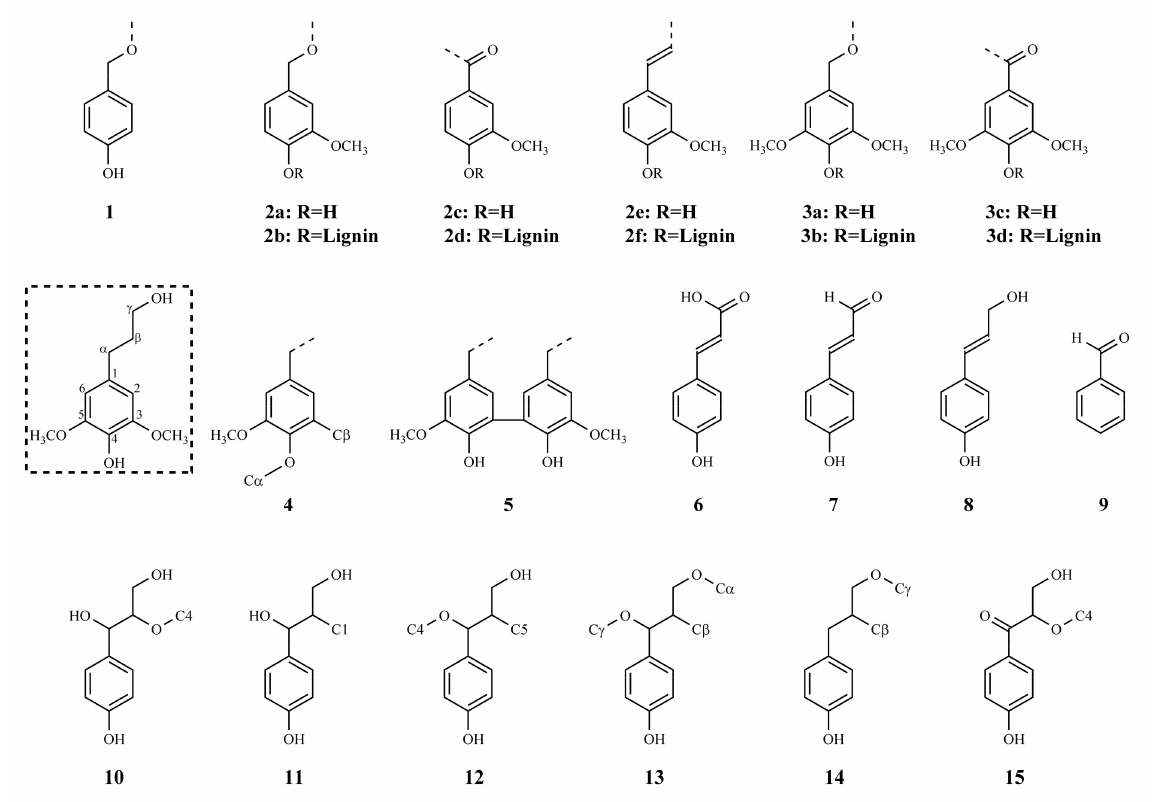
Figure 6. Lignin substructures ( 1 – 5 ) and side chains ( 6 – 15 ) corresponding to 13 C NMR